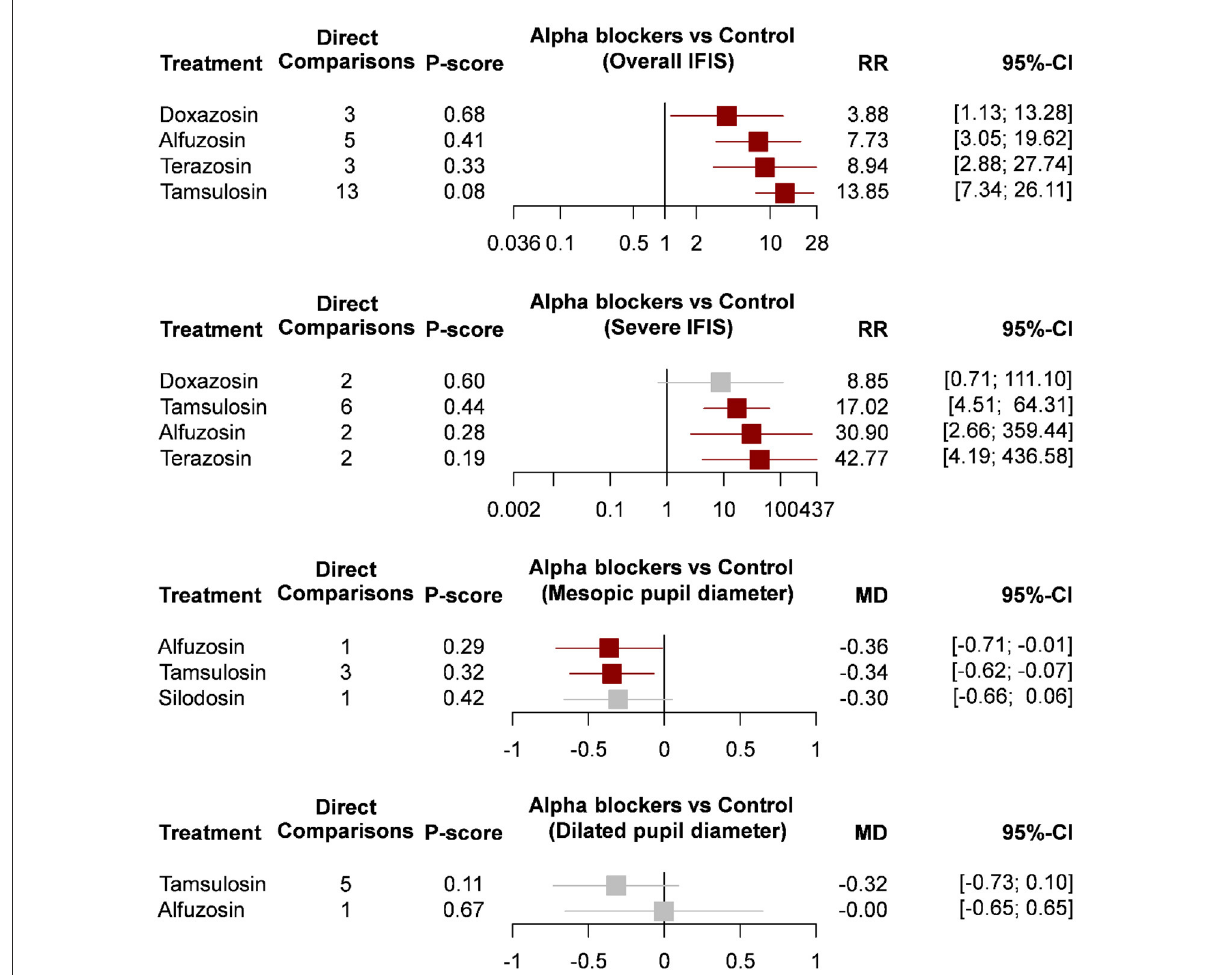
FIGURE3 Forest plots of intraoperative floppy iris syndrome and pupil diameter. CI, confidence interval; IFIS, intraoperative floppy iris syndrome; MD, mean difference; RR, risk